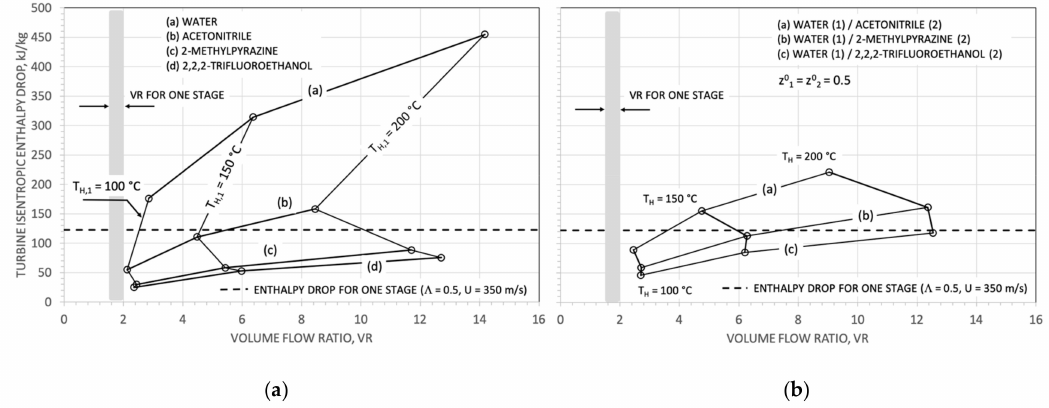
Figure 10. Turbine isentropic enthalpy drop and volume flow ratio for heat sources at di ff erent temperatures: ( a ) pure fluids and ( b ) investigated